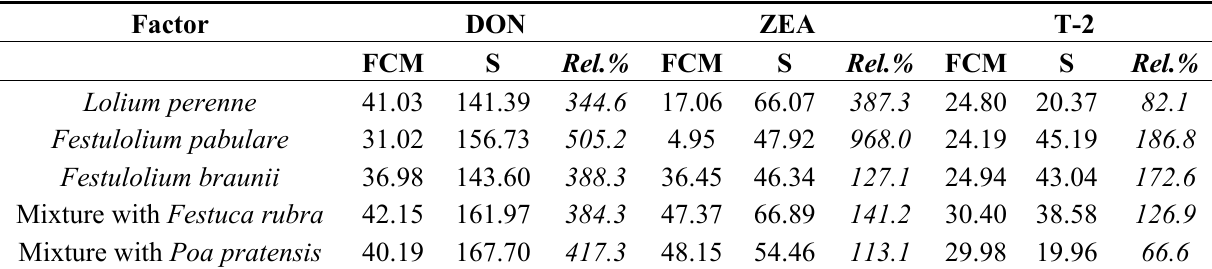
Table 3. Differences (%) in content (ppb) of deoxynivalenol (DON), zearalenone (ZEA) and T-2 toxin (T-2) between fresh-cut material and grass silages. FCM = fresh-cut material, S =